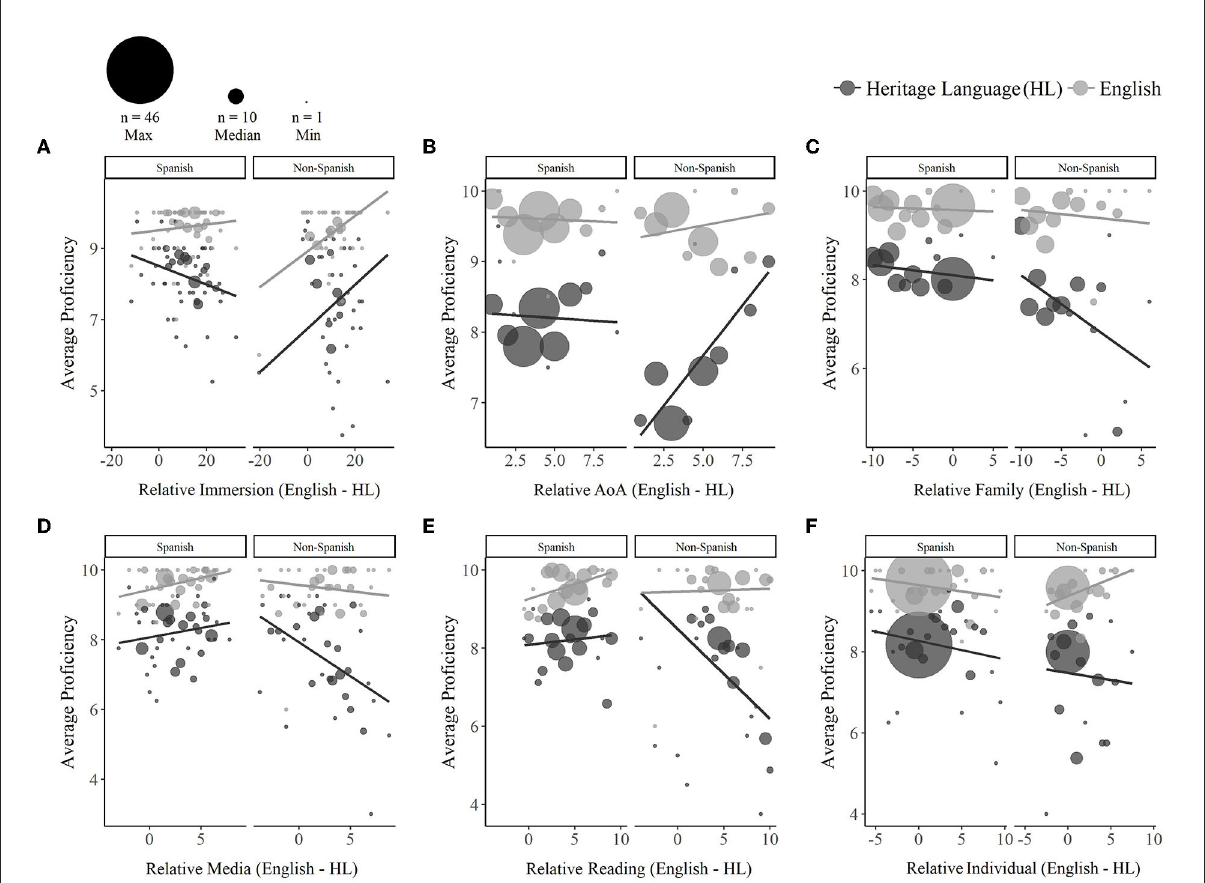
FIGURE3 Effects of relative language experience (English—HL) on self-reported HL (dark gray) and English (light gray) proficiency. Among non-Spanish bilinguals, both HL and English proficiency increased with relatively greater English (vs. HL) immersion, while for Spanish bilinguals, HL proficiency decreased with relatively greater English immersion (A) . Among non-Spanish bilinguals, lower HL proficiency was predicted by relatively earlier ages of English (vs. HL) acquisition (B) , as well as relatively higher ratings of English (vs. HL) acquisition and exposure through family (C) , media (D) , and reading (E) . Higher ratings of English (vs. HL) acquisition and exposure in individual contexts was non-significantly associated with higher English proficiency and lower HL proficiency (F) . Dot sizes reflect the number of participants contributing to each aggregated value (max = 46, median = 10, min =